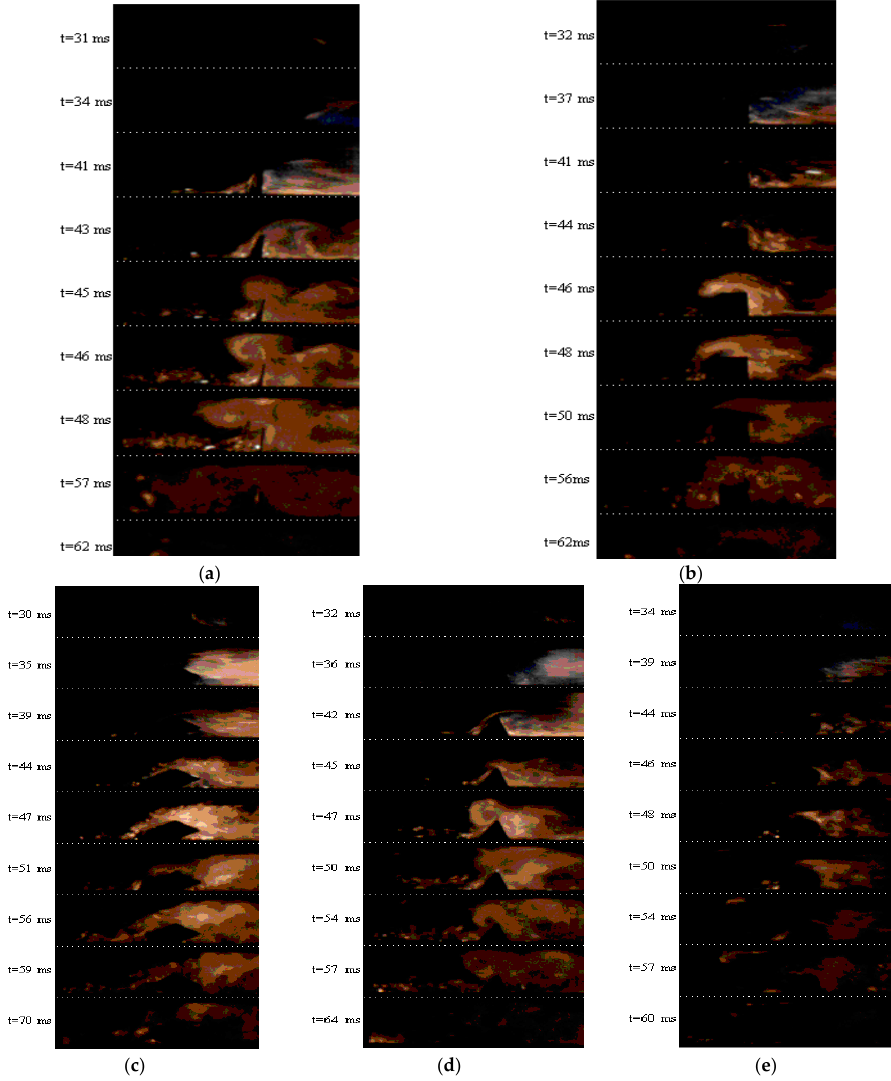
Figure 5. Local images for flame propagation by high-speed video camera fixed the solid structure obstacles in tube, 9.47 vol % CH 4 , BR = 40%, ( a ) S2; ( b ) Cu2; ( c ) T2; ( d ) Q2; and ( e ) Cy2.